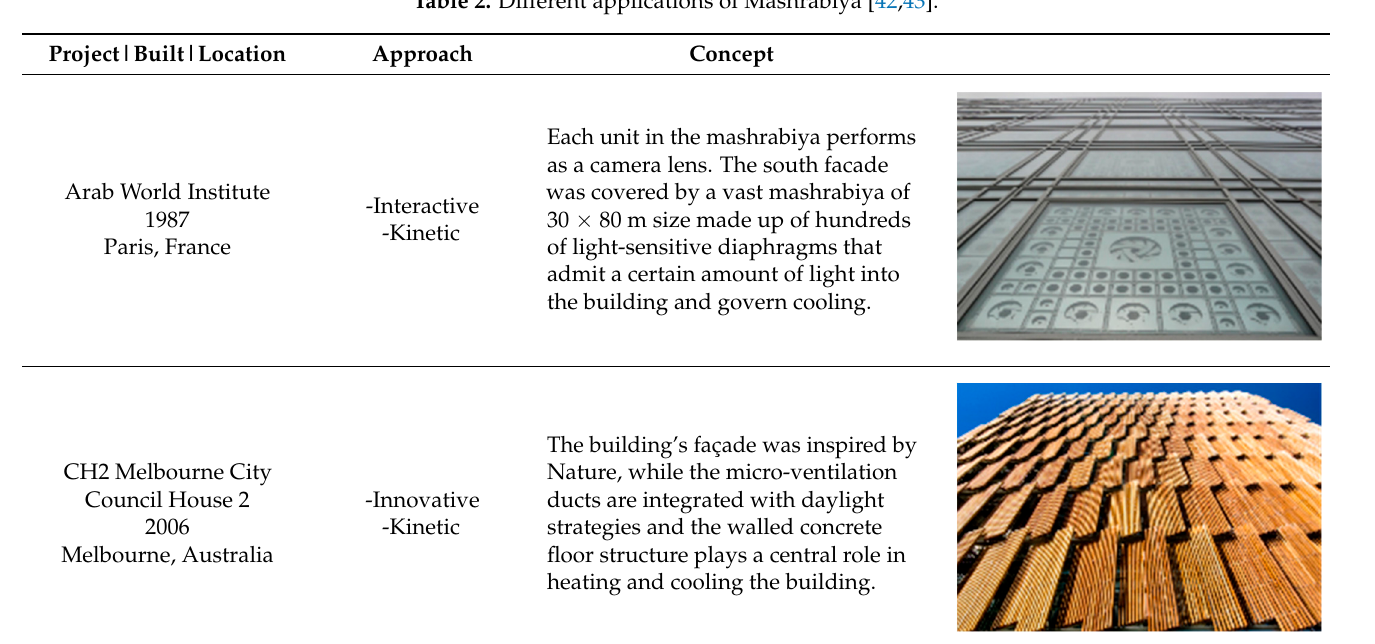
Table 2. Different applications of Mashrabiya [42,43].